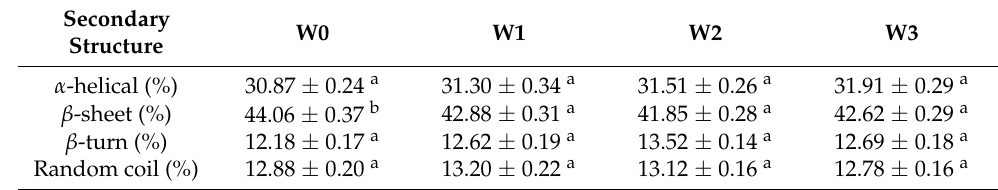
Table 4. Secondary structure of surimi with different washing